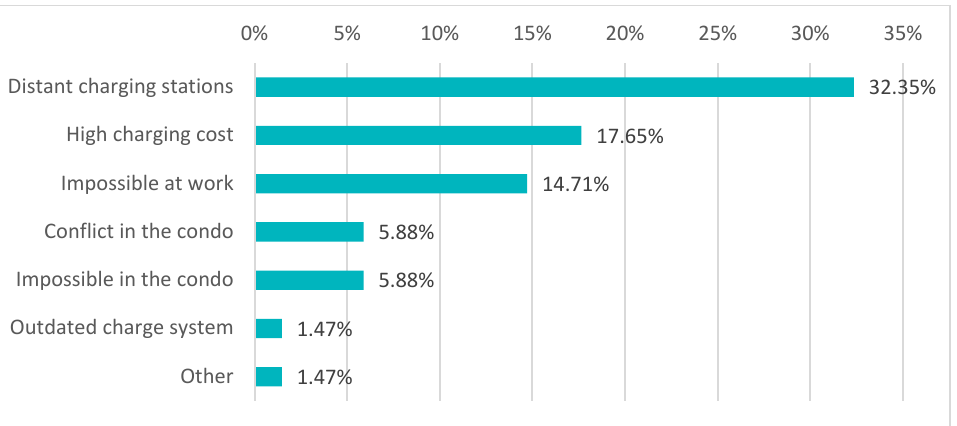
Figure 12. Perceived main advantages of an electric vehicle.